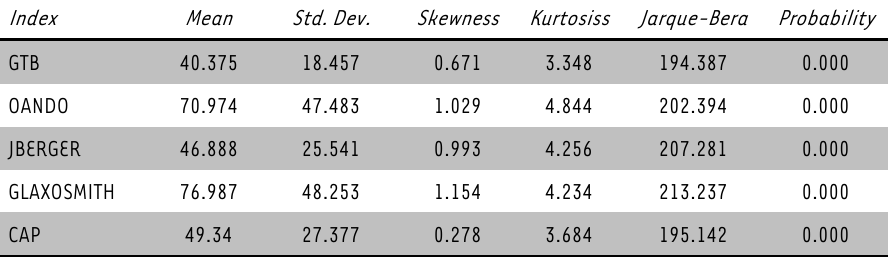
TABLE 1: Descriptive statistical summary for the daily stock prices Index Mean Std.